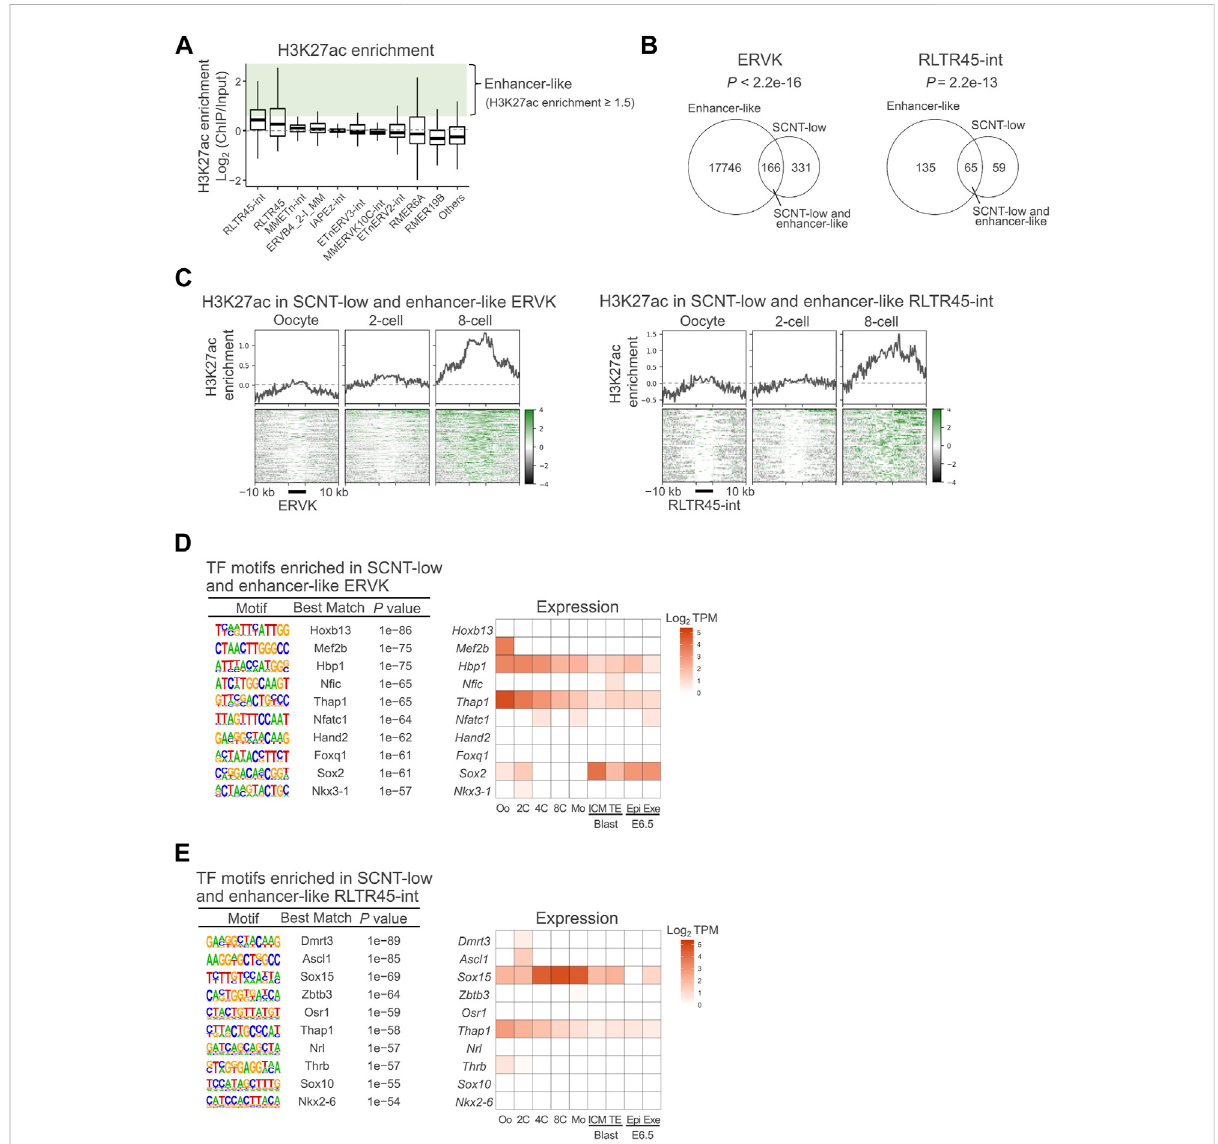
FIGURE 2 ERVKs suppressed in SCNT-derived embryos were rich in enhancer-like elements. (A) Box-and-whisker plots showing H3K27ac enrichment in the top 10 most highly expressed ERVK subfamilies. Enrichment is de fi ned as the log 2 ratio of ChIP data to the input. Enhancer-like ERVK loci were de fi ned as those with H3K27ac enrichment (ChIP/Input) ≥ 1.5 (in green). Published H3K27ac ChIP-seq data (GSE72784) were analyzed. (B) Venn diagram showing theoverlap between enhancer-like and SCNT-low ERVK (left)and RLTR45-int(right) loci. p values werecalculated byFisher ’ s exact test. (C) Heatmap and line graph showing H3K27ac enrichment at the SCNT-low, enhancer-like ERVK (left) and RLTR45-int (right) loci in MII oocytes and 2-cell and 8-cell embryos (D) Motif enrichment analysis by HOMER for SCNT-low, enhancer-like ERVK loci (left). Heatmap showing expression levels of transcription factors whose motif was enriched in SCNT-low, enhancer-like ERVK loci (right). (E) Motif enrichment analysis by HOMER for SCNT-low, enhancer-like RLTR45-int loci (left). Heatmap showing expression level of transcription factor whose motif was enriched in SCNT-low, enhancer-like RLTR45-int loci